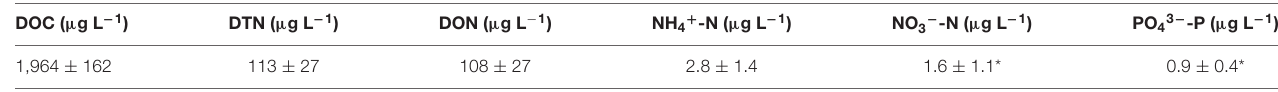
TABLE 1 | Concentrations of dissolved organic carbon (DOC), total dissolved nitrogen (DTN), organic nitrogen (DON), ammonium-nitrogen (NH 4 + -N), nitrate-nitrogen (NO 3 − -N), and phosphate-phosphorus (PO 43 − -P) in surface ice from the south western margin of the Greenland Ice Sheet (GrIS) during the 2019 ablation season (mean ± standard error, n =